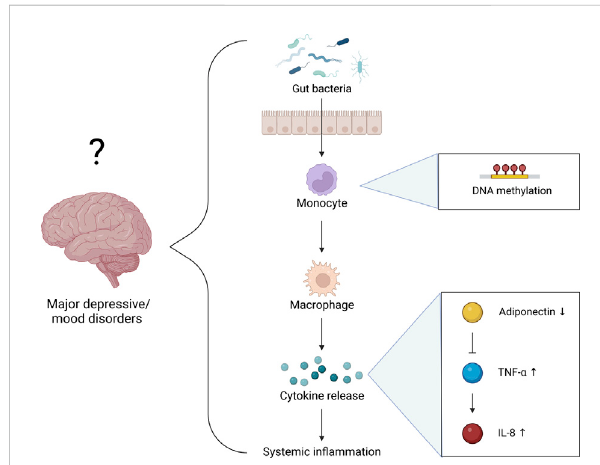
FIGURE 7 Hypothetical mechanisms underlying the function of SE as an early indicator for the progression of major depressive/mood disorders. We propose that LSE is associated with an epigenetic “ priming ” of (or increased propensity for) systemic in fl ammation and/or immunometabolic dysregulation via pathways resembling T2DM